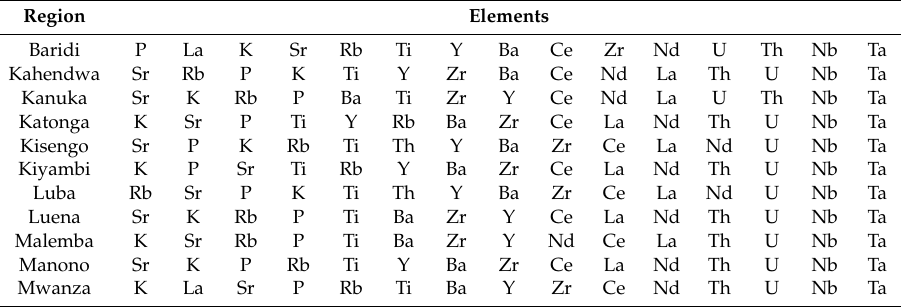
Figure 10. Spider diagram of coltan ore samples from all studied regions. Note that Manono and Luena samples show very similar pattern. For elements <LOD, half of detection limit is used for graphing purpose. Each sample is shown with a different color. Table 7. Elements in chondrite-normalized coltan ore samples in order of increasing from left to right. Average values were used in the calculations. Based on chondrite-normalized values, Ta and Nb are the first and second highest elements, respectively, followed by other elements in each deposit.